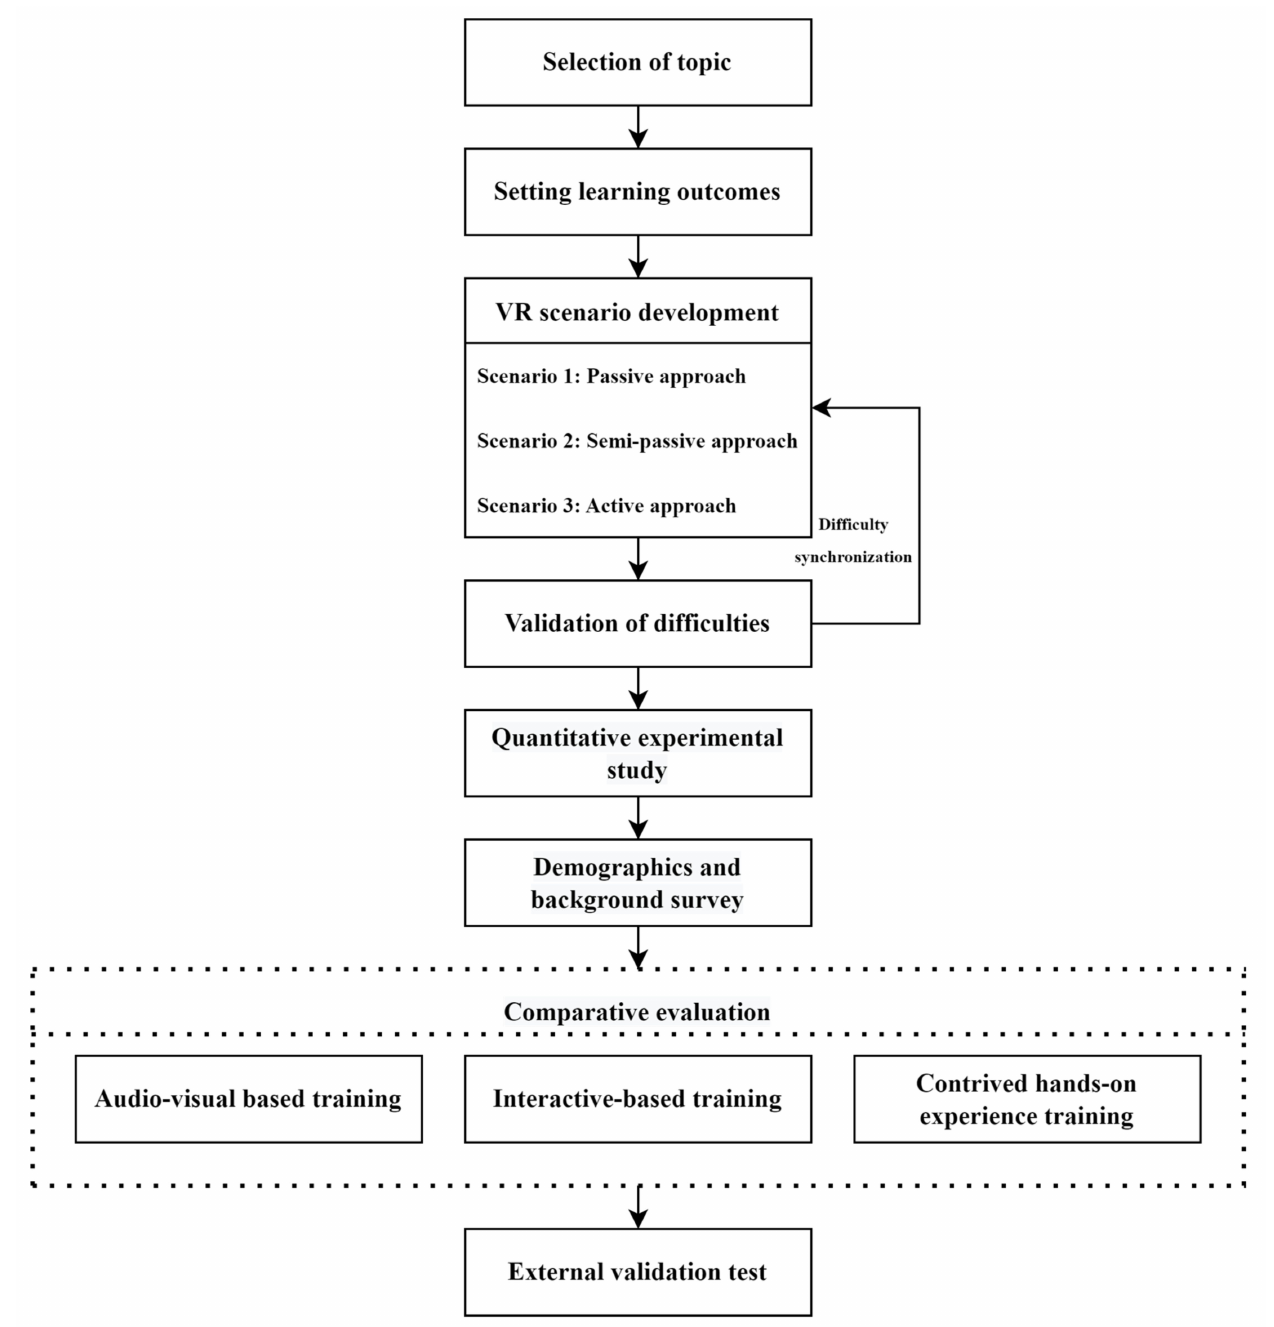
Figure 2. Research design framework to evaluate the learning effectiveness of different VR